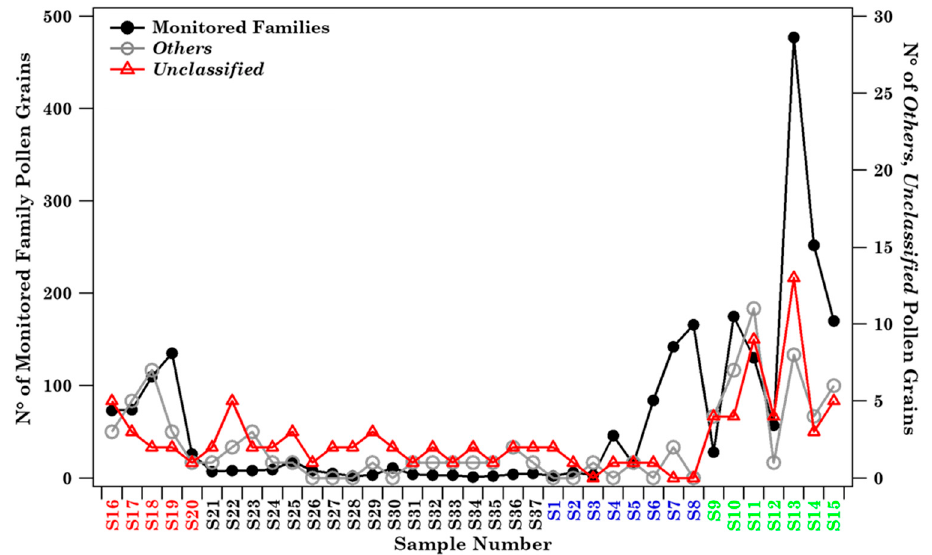
Figure 2. Total number of pollen grains per sample of the 21 allergenic pollen families monitored in Brindisi (black full dots). Open dots and triangles show the number of pollen grains due to Others and Unclassified contributions per sample. Samples are listed according to the sampling date. Each sample colour indicates a different season (red: summer, black: autumn, blue: winter, green: spring). Solid lines join the discrete data points to better visualise their respective time evolution.